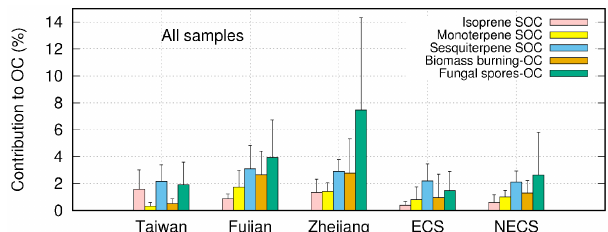
Figure 9. Contributions of OC (ngCm − 3 ) from biogenic primary emission (biomass burning OC and fungal spore OC) and biogenic SOC to OC (%) in different sampling regions. Taiwan, Fujian, and Zhejiang refer to the waters around Taiwan, Fujian, and Zhejiang; ECS represents East China Sea waters; NECS represents the north- ern waters of the